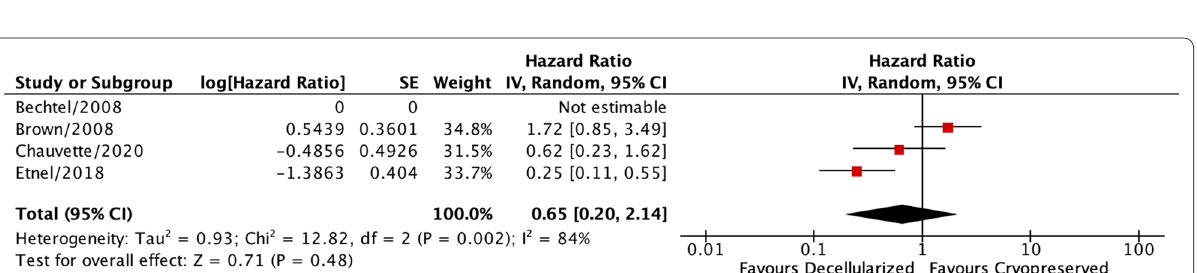
Fig. 3 Forest plot comparing follow-up allograft dysfunction in decellularized allografts versus cryopreserved allografts for patients undergoing right ventricular outflow tract reconstruction during the Ross procedure. IV inverse variance, CI confidence interval